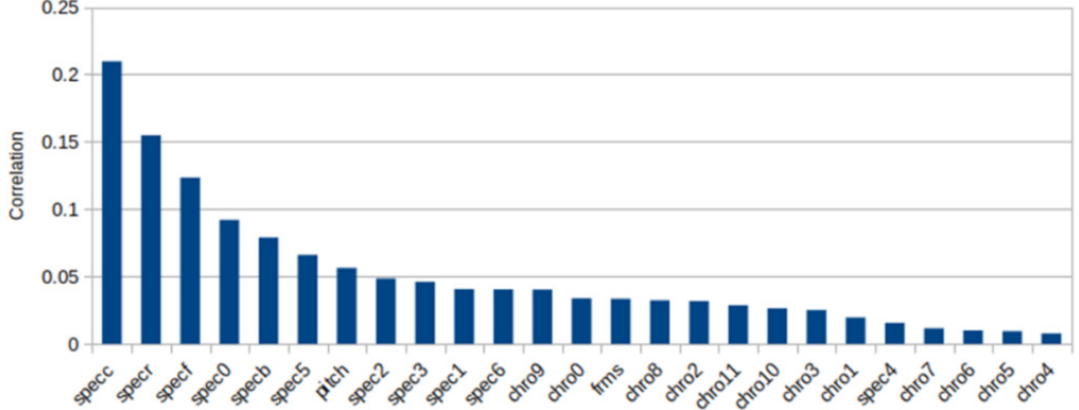
Figure 6. Correlation between 25 parameters and accuracy recognition. specc: spectral centroid, specr: spectral rolloff, specf: spectral flatness, specb: spectral bandwidth, spec0 ‐ 6: spectral contrast, chro0 ‐ 11: chroma, frms: root ‐ mean ‐ square (RMS) value calculated for each frame.